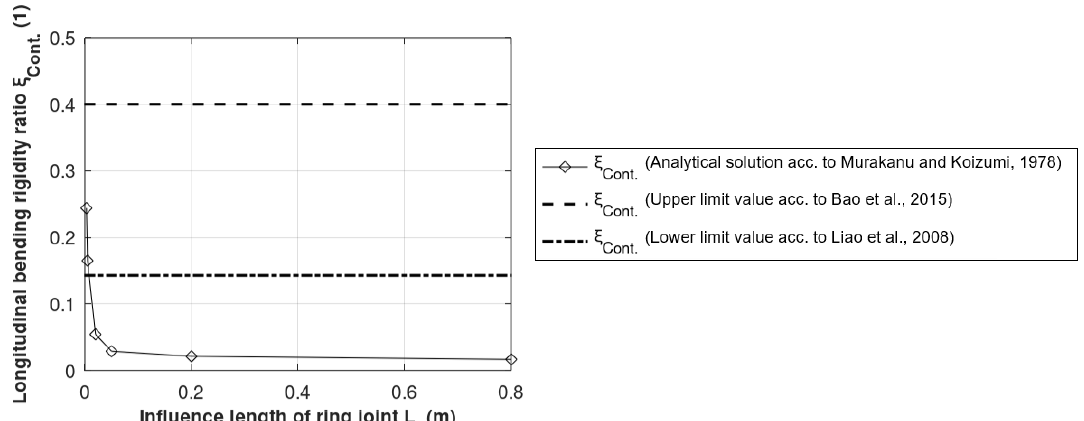
Fig. 11. Relationship between influence length of ring joint L